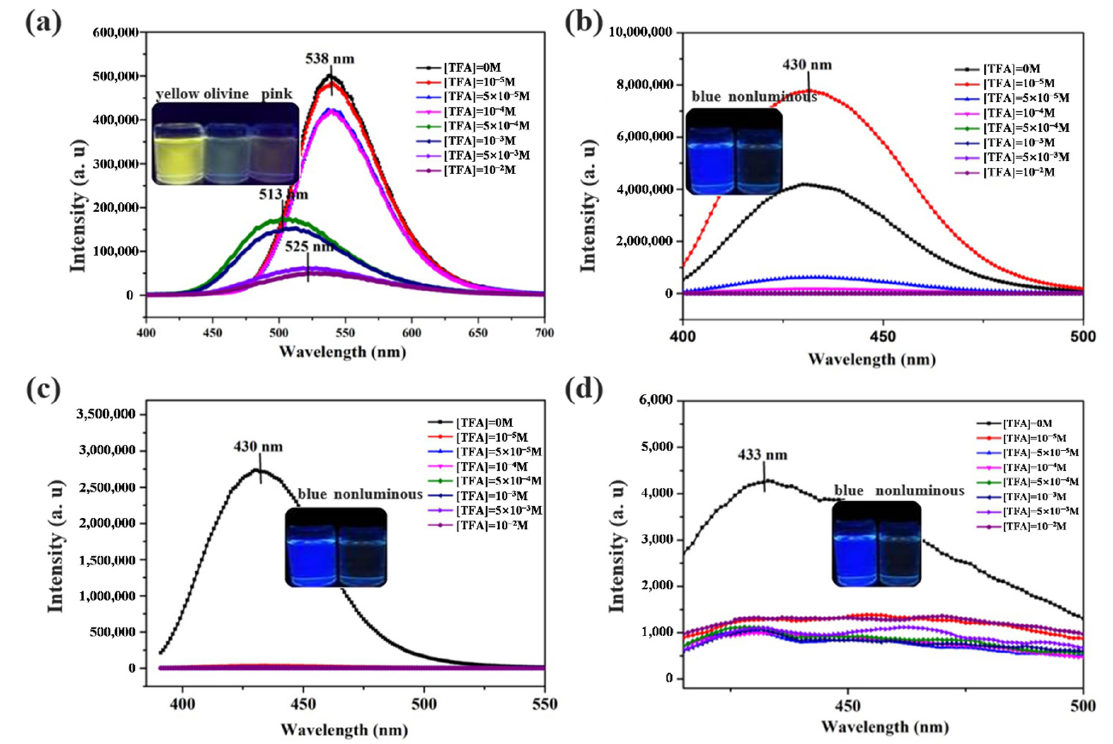
Figure 11. Changes in PL spectra and fluorescent colors of ( a ) PI , ( b ) NI , ( c ) TI and ( d ) FI solutions (5 × 10 − 5 mol/L in DCM) with increasing concentrations of TFA. λ ex = 365 nm.